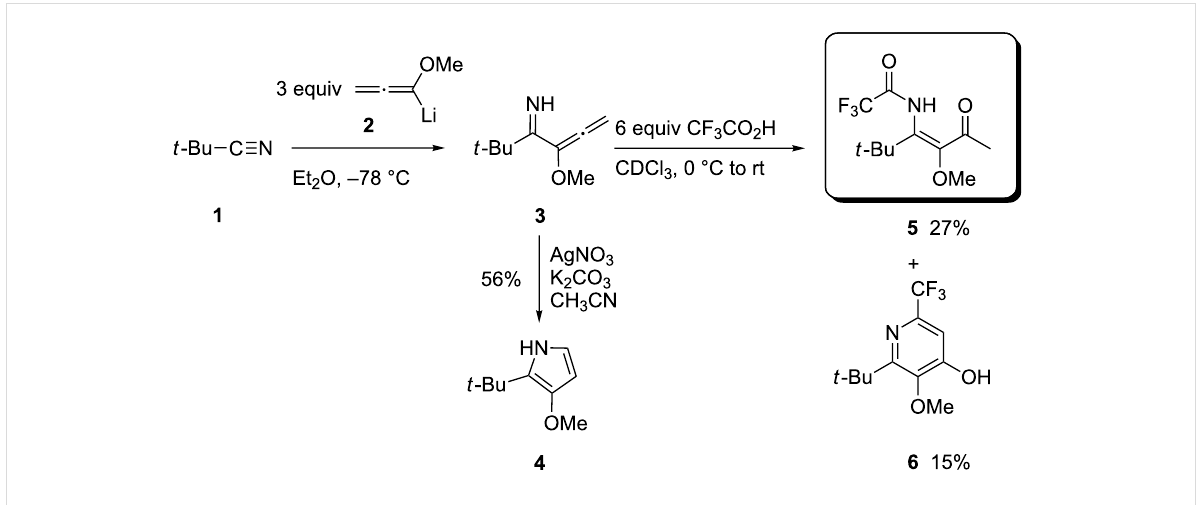
Scheme 1: Discovery of the LANCA three-component reaction. The reaction of pivalonitrile ( 1 ) with lithiated methoxyallene 2 leads to allenyl-substi- tuted imine 3 which upon reaction with trifluoroacetic acid affords β -ketoenamide 5 and pyridin-4-ol derivative 6